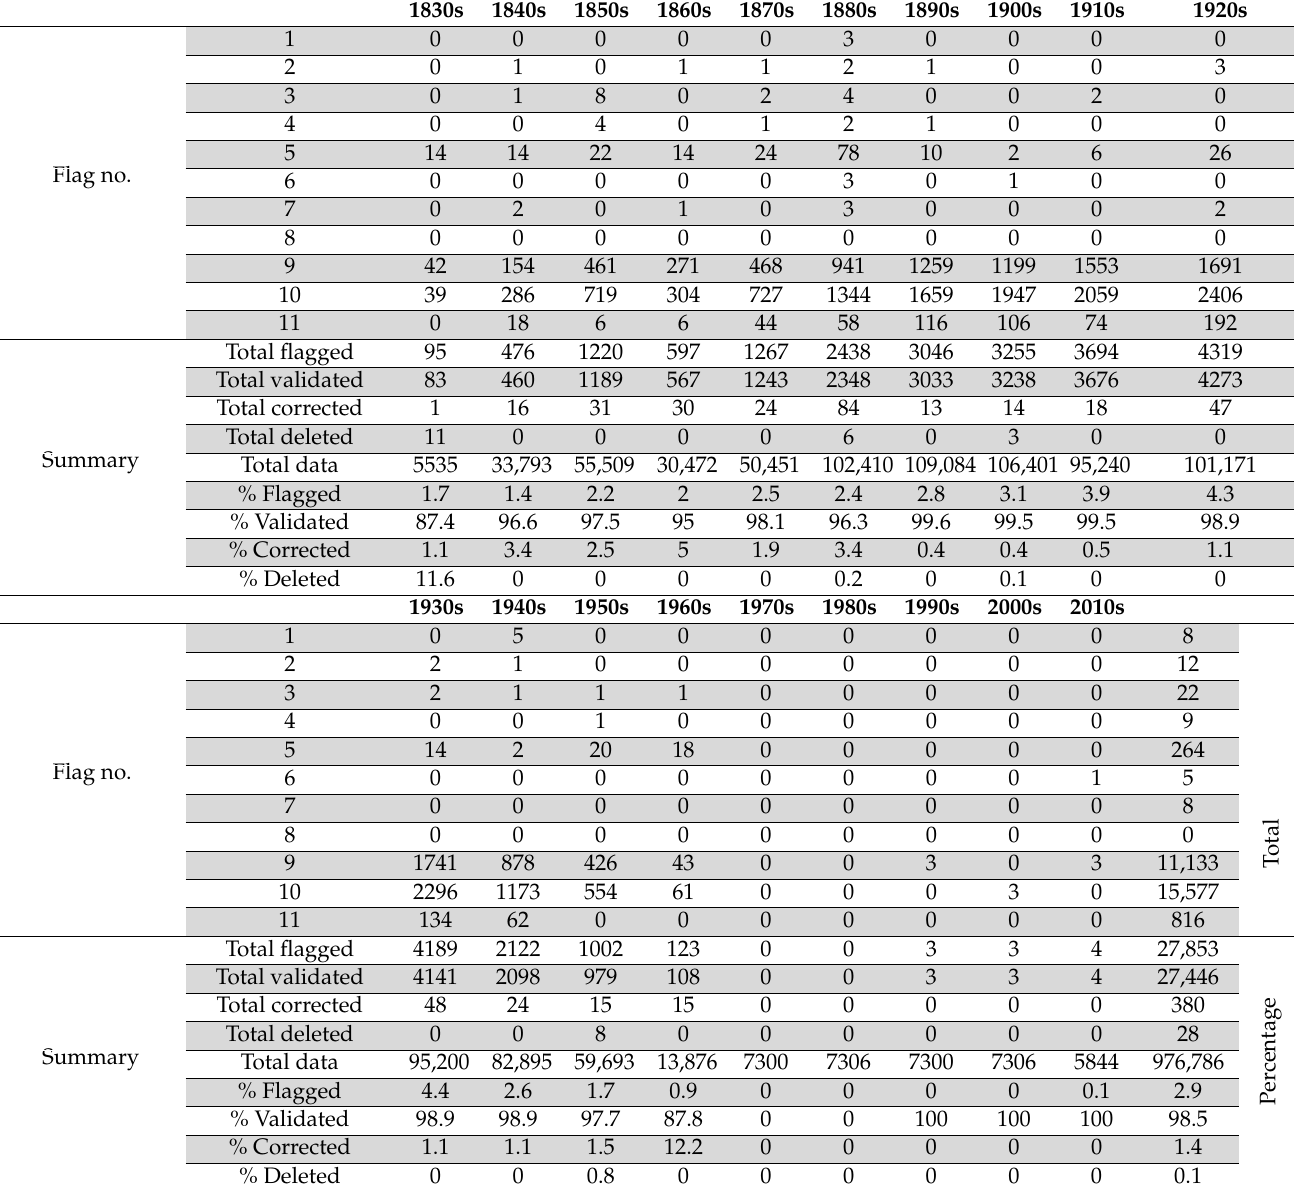
Table 5. Total of flagged and percentage of flagged, validated, corrected, and deleted air temperature data per each flag and per